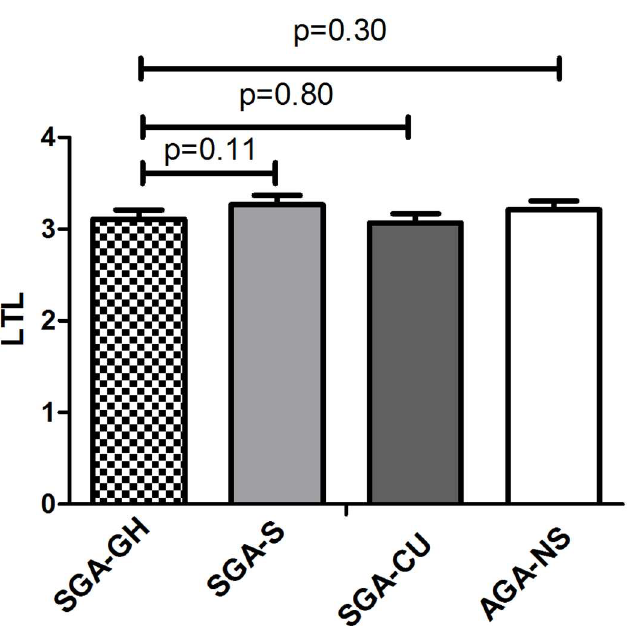
Fig 2. Comparison of LTL in the subgroups. Values are given as estimated means ± SEM, adjustedfor gender, age and gestationalage. SGA-GH = birth length < -2 SDS, treated with growth